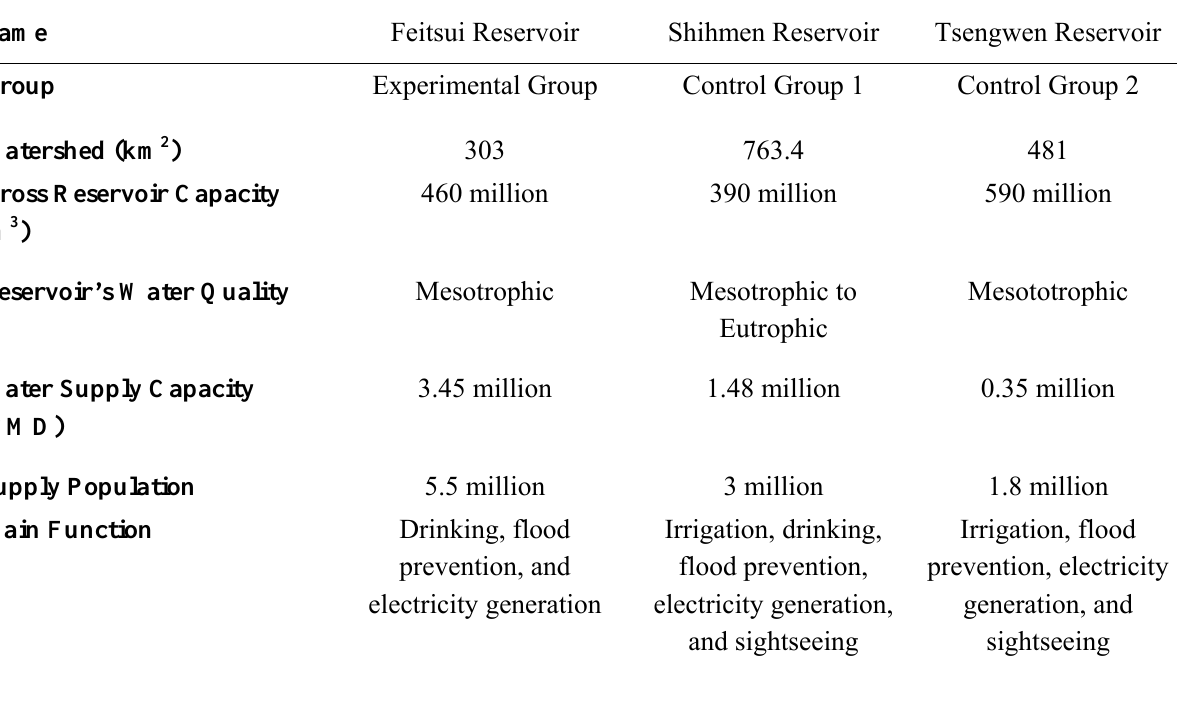
Table 1. Reservoir basic